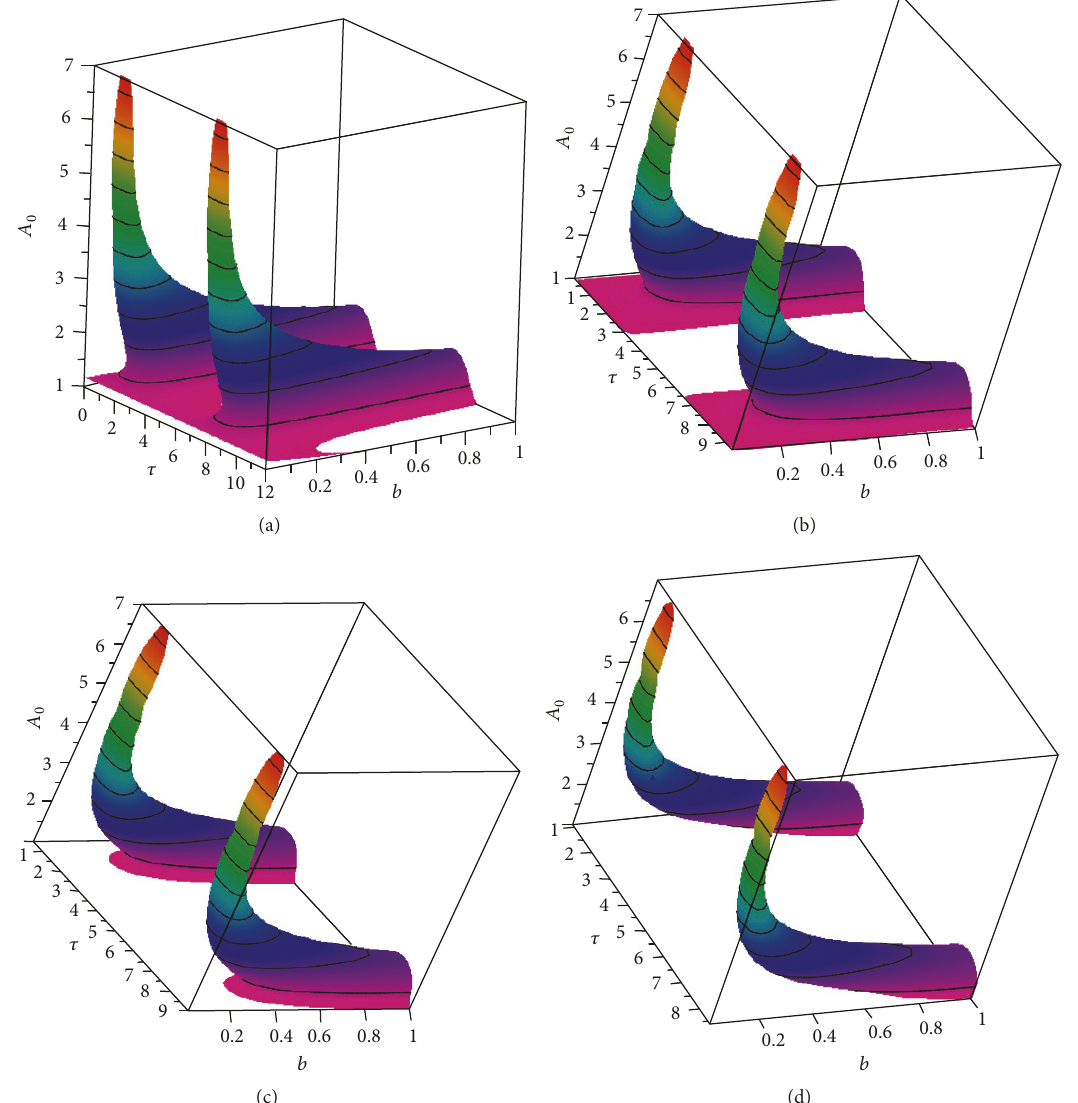
Figure 7: 3D surface plot of vibration amplitude of the system with changing feedback gains and time delays. (a) 𝑓 = 2.2 ; (b) 𝑓 = 2.0 ; (c) 𝑓 = 1.8 ; (d) 𝑓 = 1.5